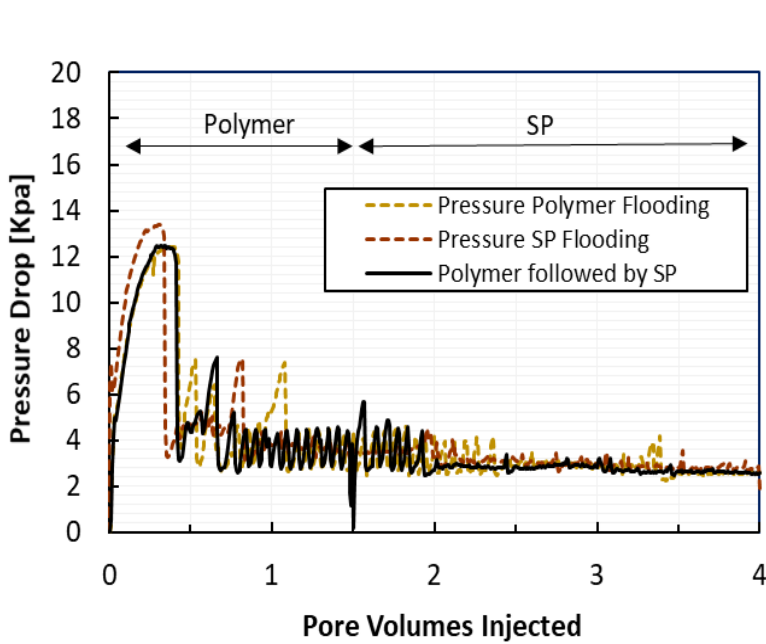
Figure 16. Cumulative oil recovery ( A ) and pressure drops ( B ) by polymer followed by SP at 0.3 mL/min for the displacement of crude oil.